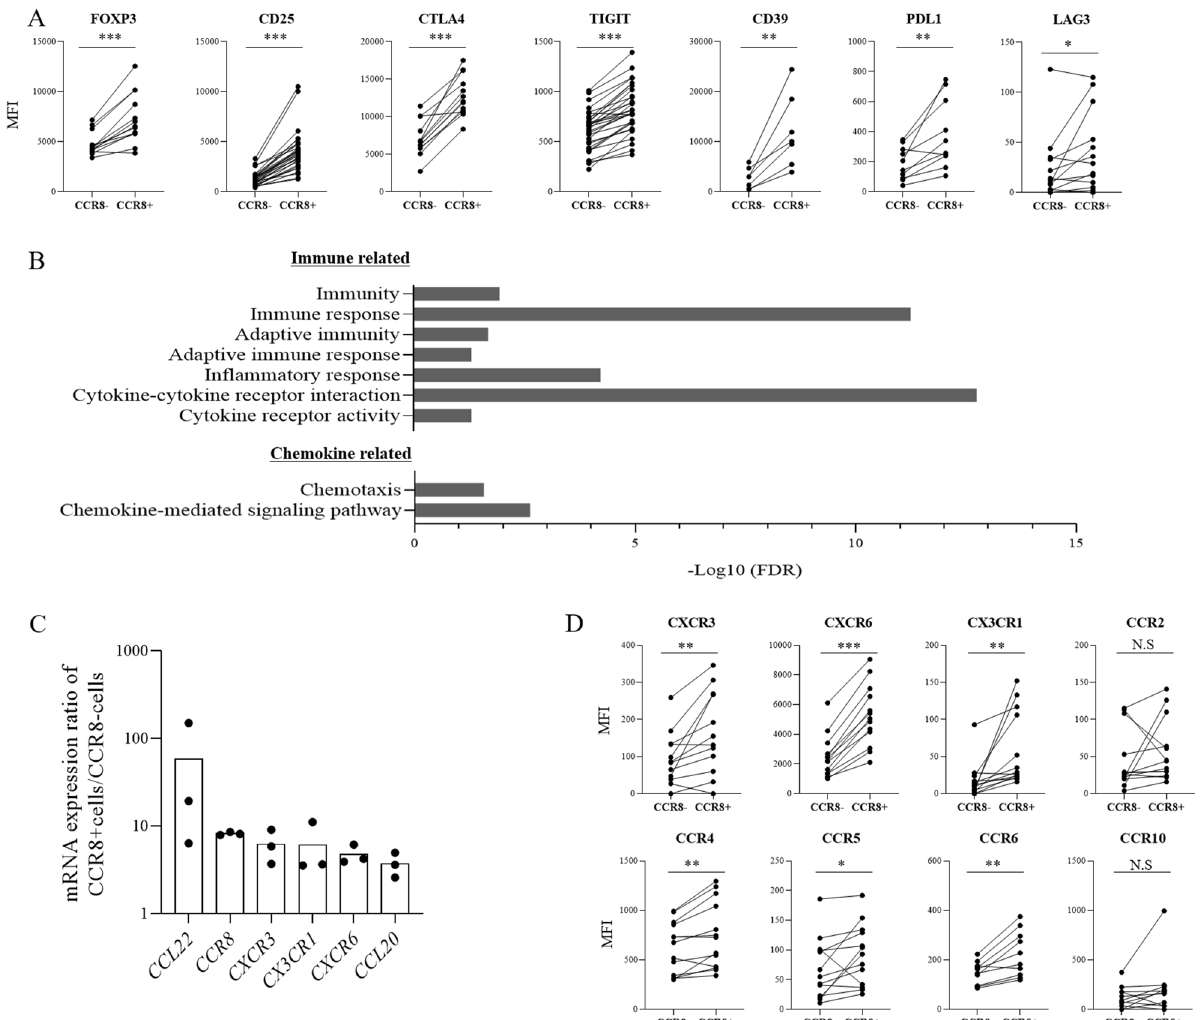
Figure 3. Characteristics of lung tumor–infiltrating CCR8+ and CCR8− Tregs. ( A ) Protein expression levels of Treg-related molecules were analyzed by flow cytometry (n = 7–22). The mean fluorescence intensity (MFI) of each stained molecule on CCR8− Tregs and CCR8+ Tregs (gated on live CD45+ CD3+ CD4+ Foxp3+ cells) is shown. Lines connect data from the same donor samples. ( B ) CCR8+ Tregs and CCR8− Tregs (gated on live CD45+ CD3+ CD4+ CD25 high cells) were sorted from lung TICs obtained from 3 patients. RNA-sequencing was performed and differentially expressed genes (DEGs) between CCR8+ Tregs and CCR8− Tregs were identified. Gene Ontology (GO) enrichment analysis of the top 100 upregulated DEGs in CCR8+ Tregs sorted by p-value was performed using the DAVID bioinformatics tool. Enriched immune-related terms categorized in biological process were extracted. The minus logarithm of False Discovery Rate (FDR) is shown. ( C ) mRNA expressions of chemokine-related genes were analyzed and the ratios of mRNA expression in CCR8+ Tregs to that in CCR8− Tregs are shown (n = 3). ( D ) Protein expression levels of chemokine receptors were detected by flow cytometry. The MFI of each stained molecule on CCR8− and CCR8+ Tregs (gated on live CD45+ CD3+ CD4+ Foxp3+ cells) is shown (n = 10–13). Lines connect data from the same donor samples. Statistical significance was determined by paired t-test (* p ≤ 0.05; ** p < 0.01; *** p <